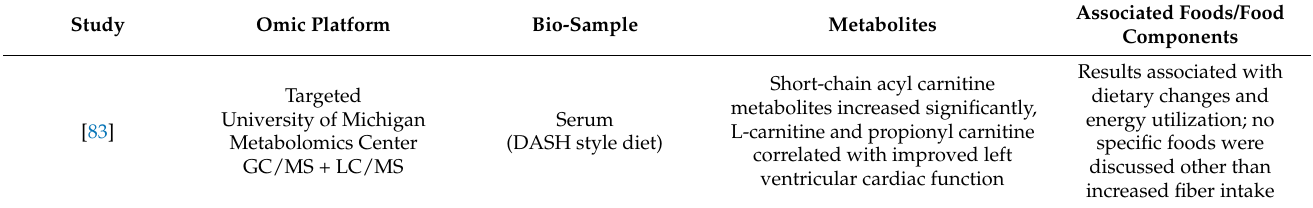
Table A2. Metabolite markers and relationship to DASH diet